Question: Give a one-sentence summary of this figure.
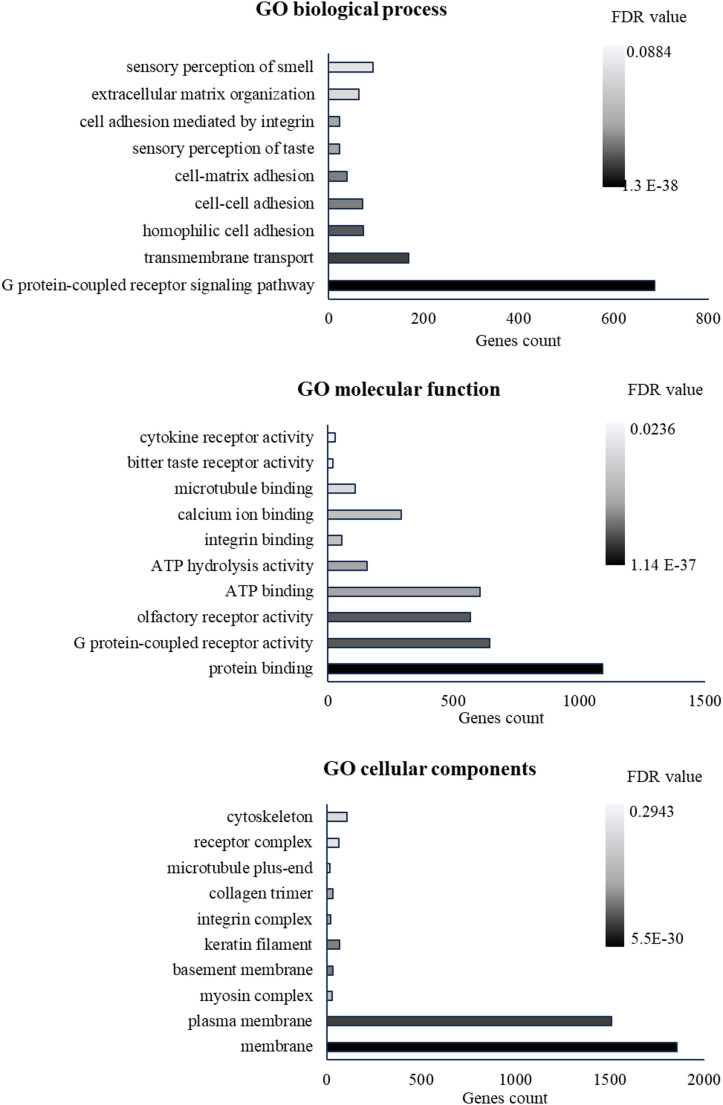
Answer: Number of mutated genes affecting biological processes, molecular functions, and cellular components. Top 10 GO pathways based on FDR values < 0.05 were selected the highest number of genes were involved in G-protein coupled receptor signaling pathway, protein binding, and membrane component